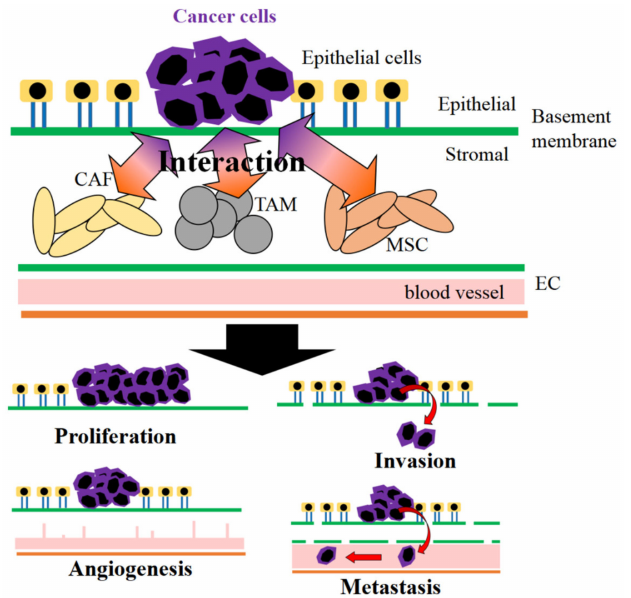
Figure 2. Cancer cells interact with various stromal cells of cancer-associated fibroblasts (CAF), tumor-associated macrophages (TAM), mesenchymal stem cells (MSC), and endothelial cells (EC), leading to the pathological maintenance and promotion of cancer characteristics.